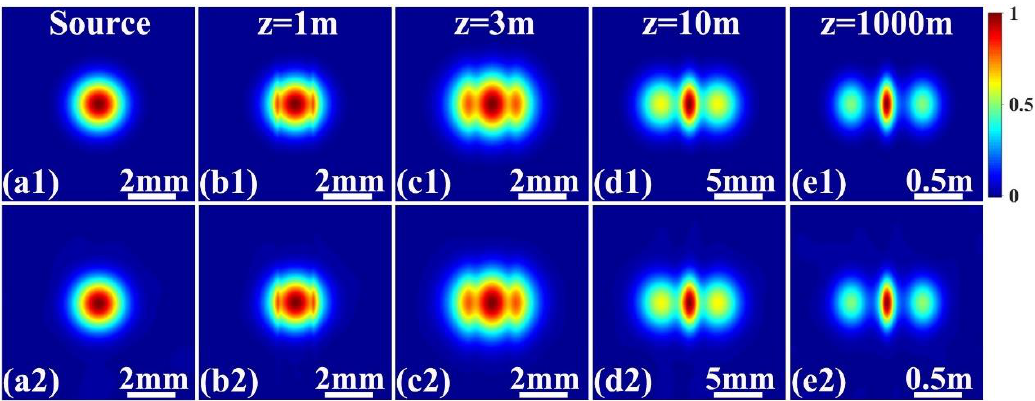
Figure 1. Evolution of the square of the modulus of the degree of coherence of the partially coherent elegant Hermite – Gaussian beam with the propagation distance in free space. ( a1 – e1 ) Results obtained from the analytical formula; ( a2 – e2 ) the corresponding results obtained using our numerical